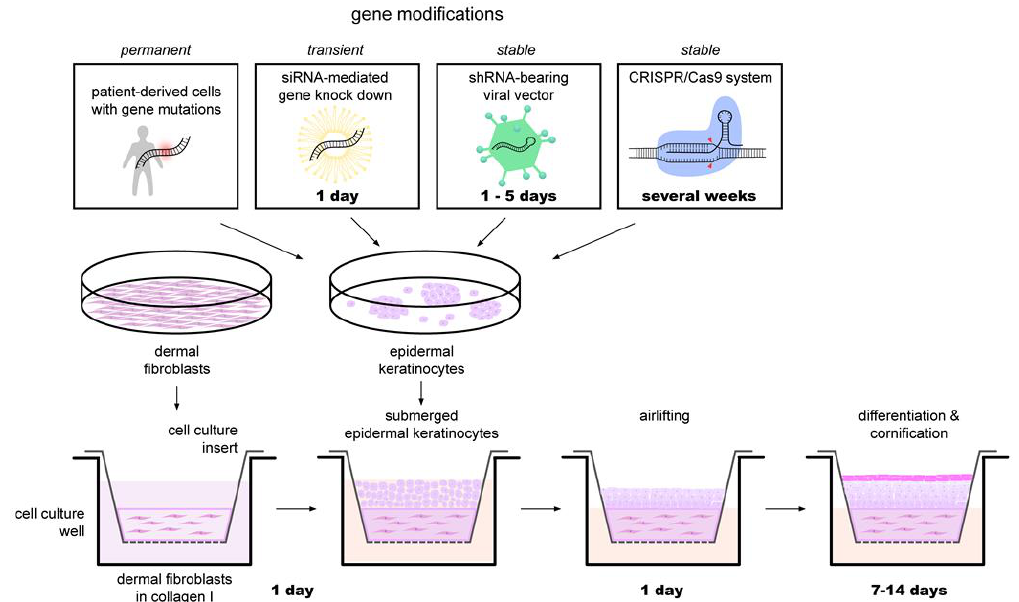
Figure 2. Three-dimensional organotypic skin models as a means for the study of hereditary disorders of cornification in vitro. Patient-derived cells or genetically modified primary human keratinocytes are the source for investigating hereditary cornification disorders with human organotypic skin models. Dermal fibroblasts are seeded in a cell culture insert submerged in a collagen I suspension. After two hours, the suspension is replaced with keratinocyte growth medium to equilibrate the collagen gel for another two hours. Next, keratinocytes are carefully layered onto the fibroblast gel matrix and cultivated overnight. Medium is then exchanged and added only to the outer cell culture well with the keratinocytes residing at the air–liquid interphase. Morphological and functional analysis of the three-dimensional organotypic skin models is done once differentiation and cornification have taken place.